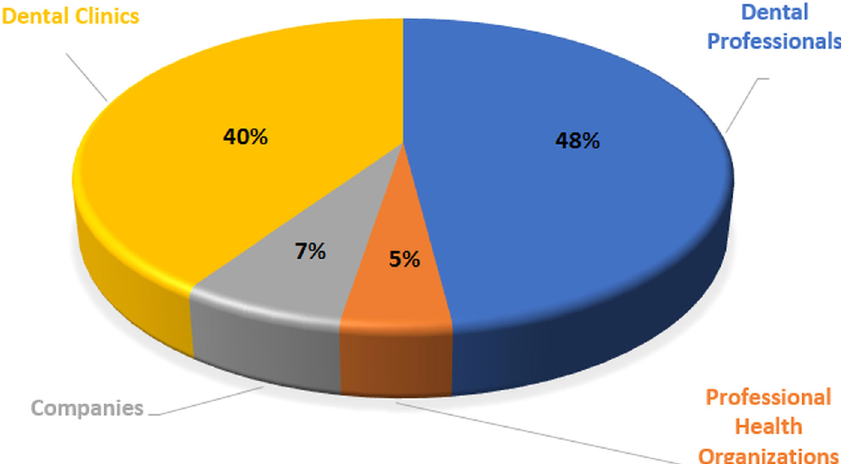
Figure 2. % distribution of all analysed websites according to the website source.